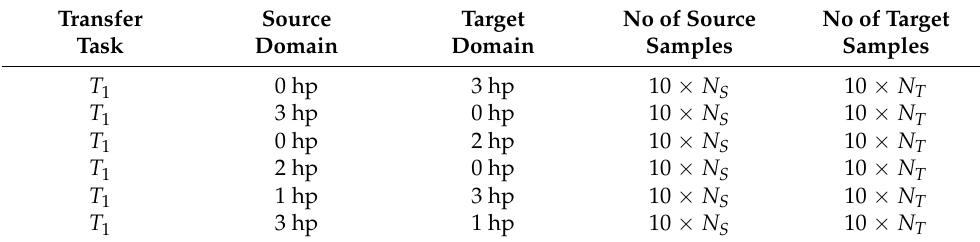
Table 3. Details of each transfer task for CWRU dataset.